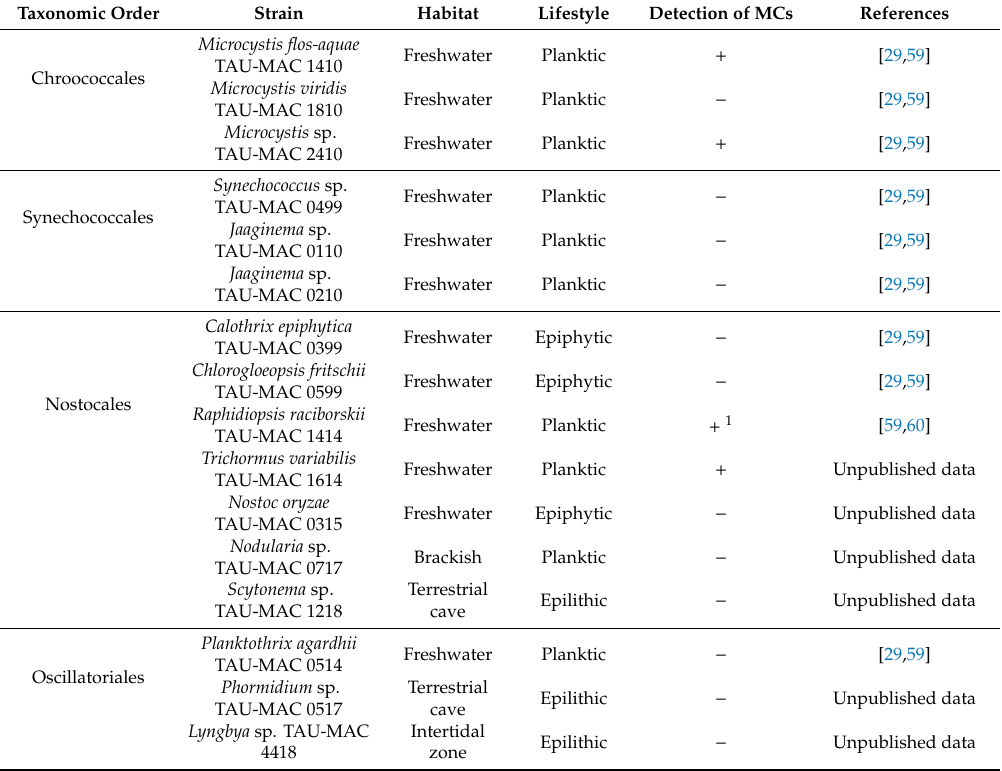
Table 3. The cyanobacterial strains used here and relevant information. “ + ”: microcystins (MCs) detected. “ − “: no MCs